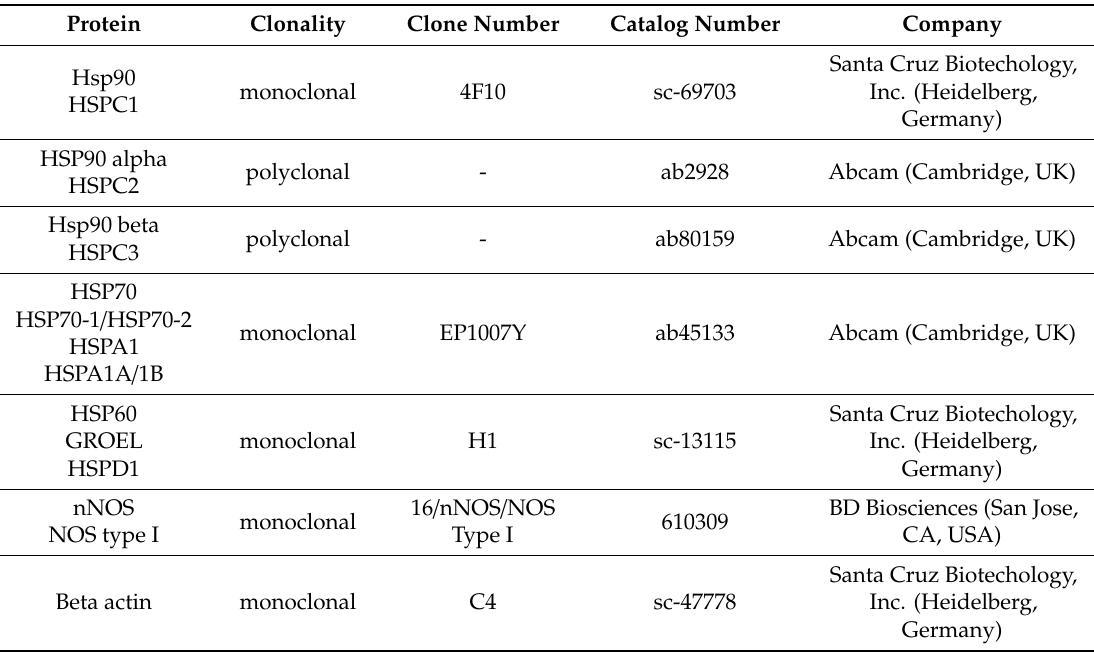
Table 2. The list of primary antibodies used in the current